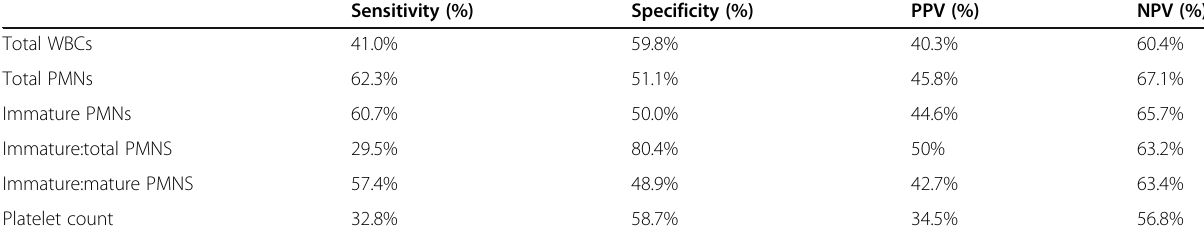
Table 8 Diagnostic performance of individual items of HSS for diagnosis of culture-proven